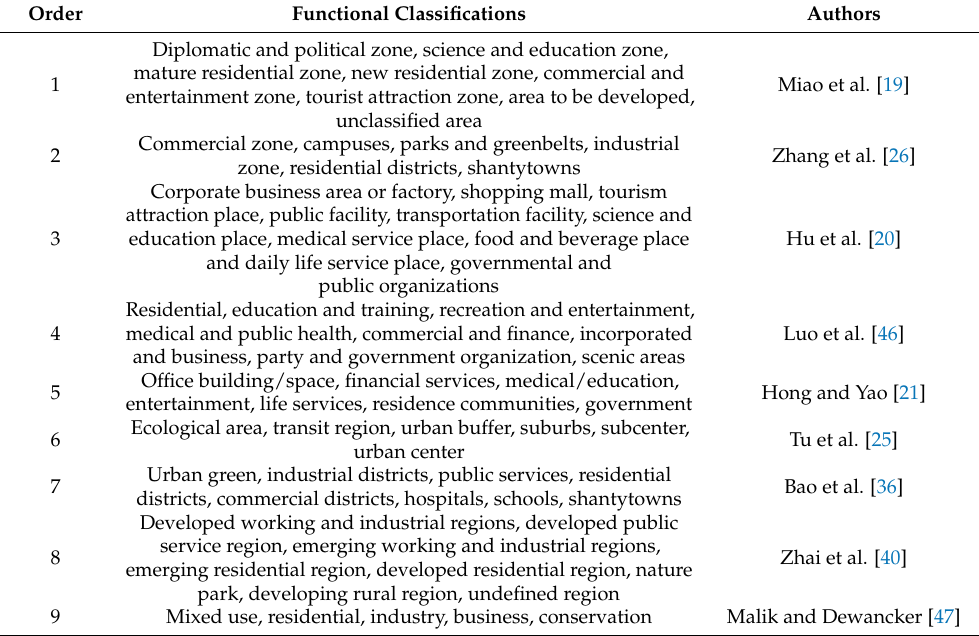
Table 1. Functional zoning classifications by different